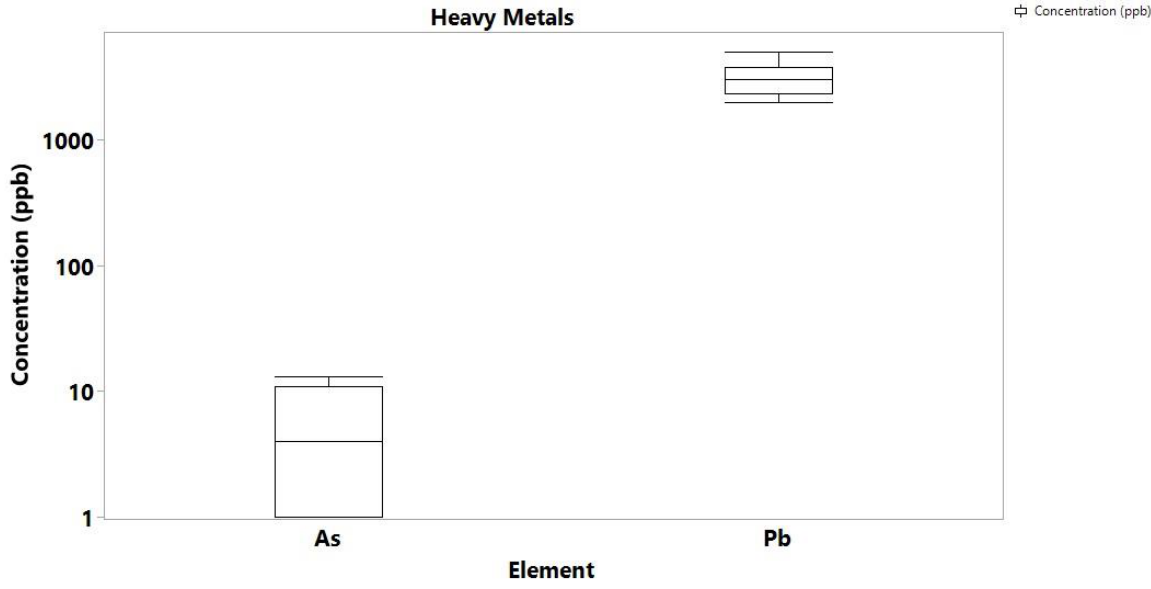
Figure 4. Box plot of toxic metals/metalloids concentration in soil samples.